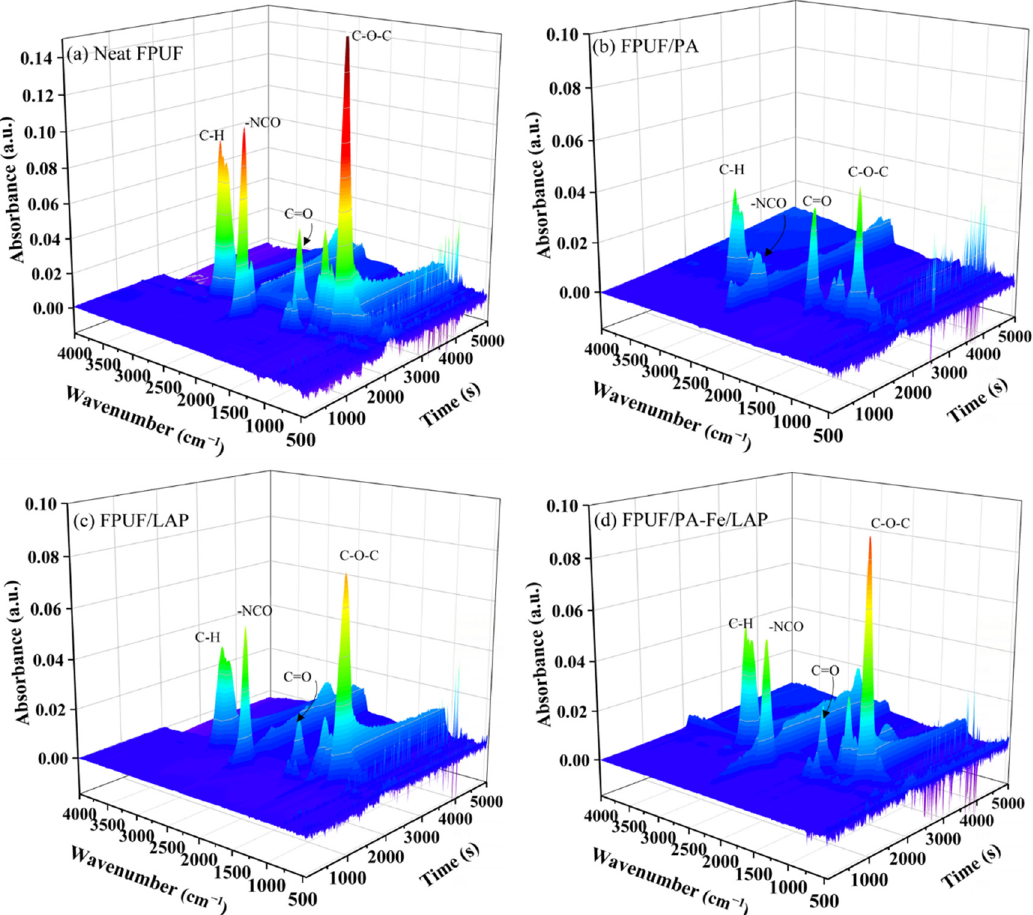
Figure 3. 3D FTIR spectra of neat FPUF ( a ), FPUF/PA ( b ), FPUF/LAP ( c ), and FPUF/PA-Fe/LAP ( d ).